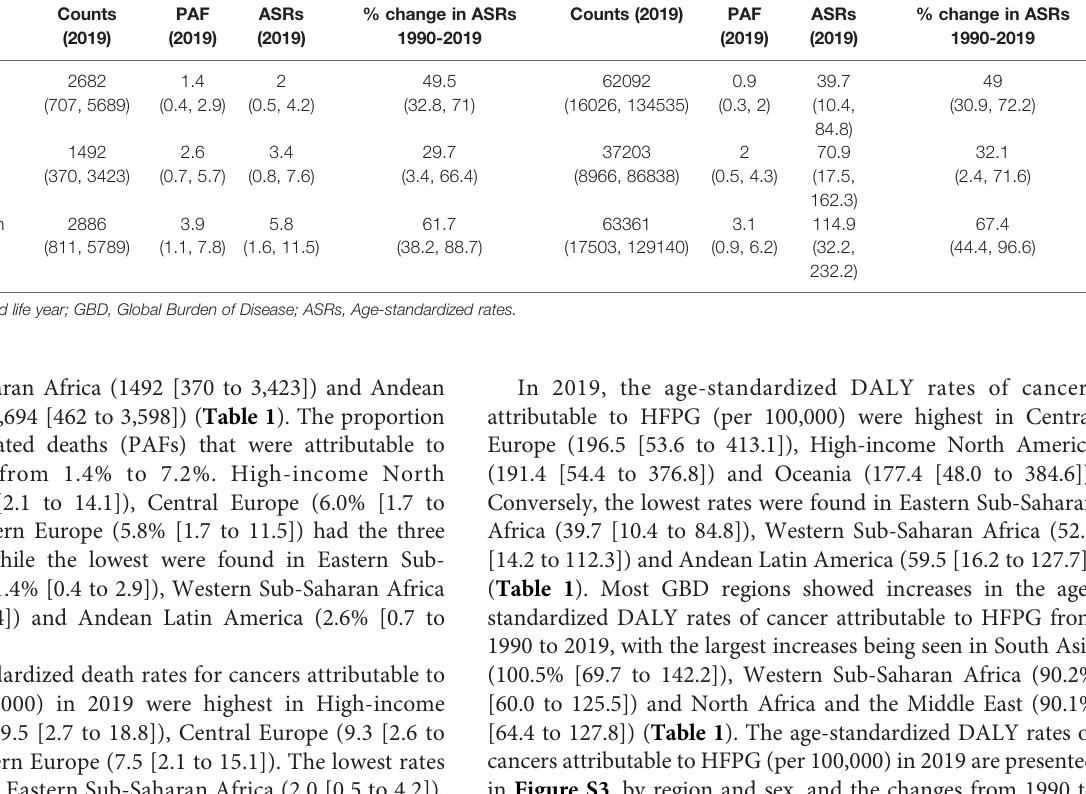
( Table 1 ). Most GBD regions showed increases in the age- standardized DALY rates of cancer attributable to HFPG from 1990 to 2019, with the largest increases being seen in South Asia (100.5% [69.7 to 142.2]), Western Sub-Saharan Africa (90.2% [60.0 to 125.5]) and North Africa and the Middle East (90.1% [64.4 to 127.8]) ( Table 1 ). The age-standardized DALY rates of cancers attributable to HFPG (per 100,000) in 2019 are presented in Figure S3 , by region and sex, and the changes from 1990 to 2019 are presented in Figure S4 , by region and